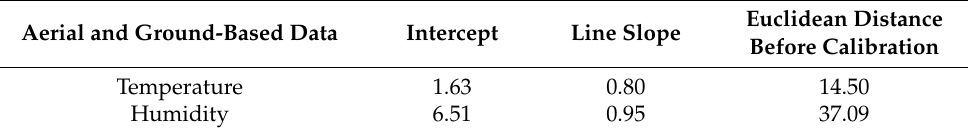
Table 6. Aerial temperature and humidity intercept, line slope, and Euclidean distance before calibration. Aerial and Ground-Based